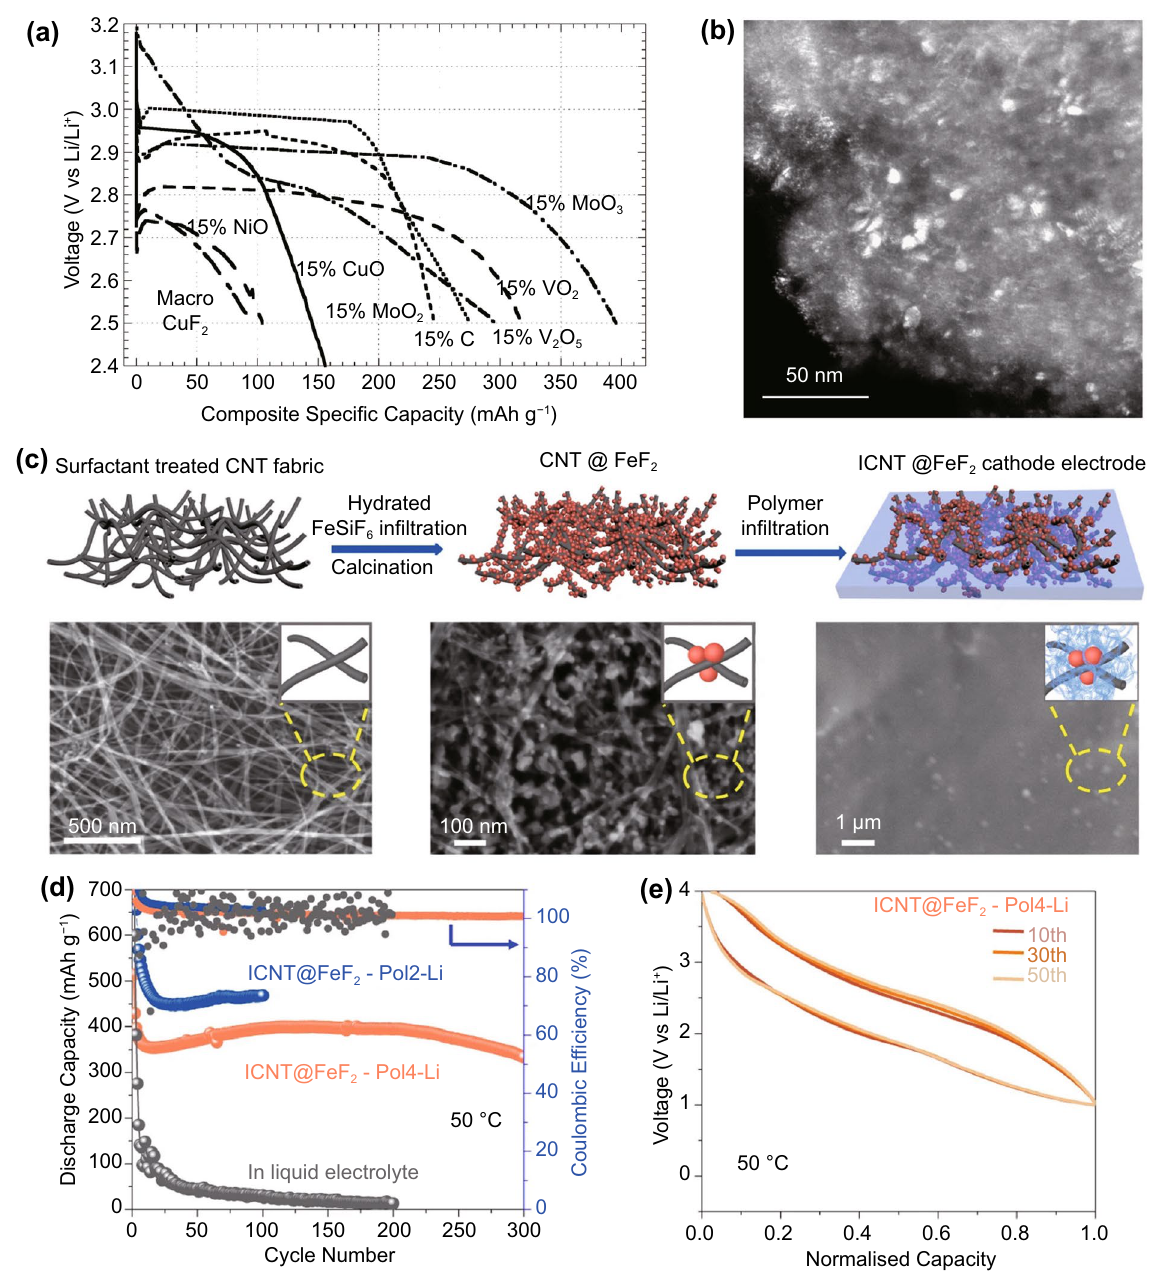
Fig. 12 a Discharge capacity of CuF 2 composite cathodes with different conductive matrices , and b a transmission electron micrograph depict- ing